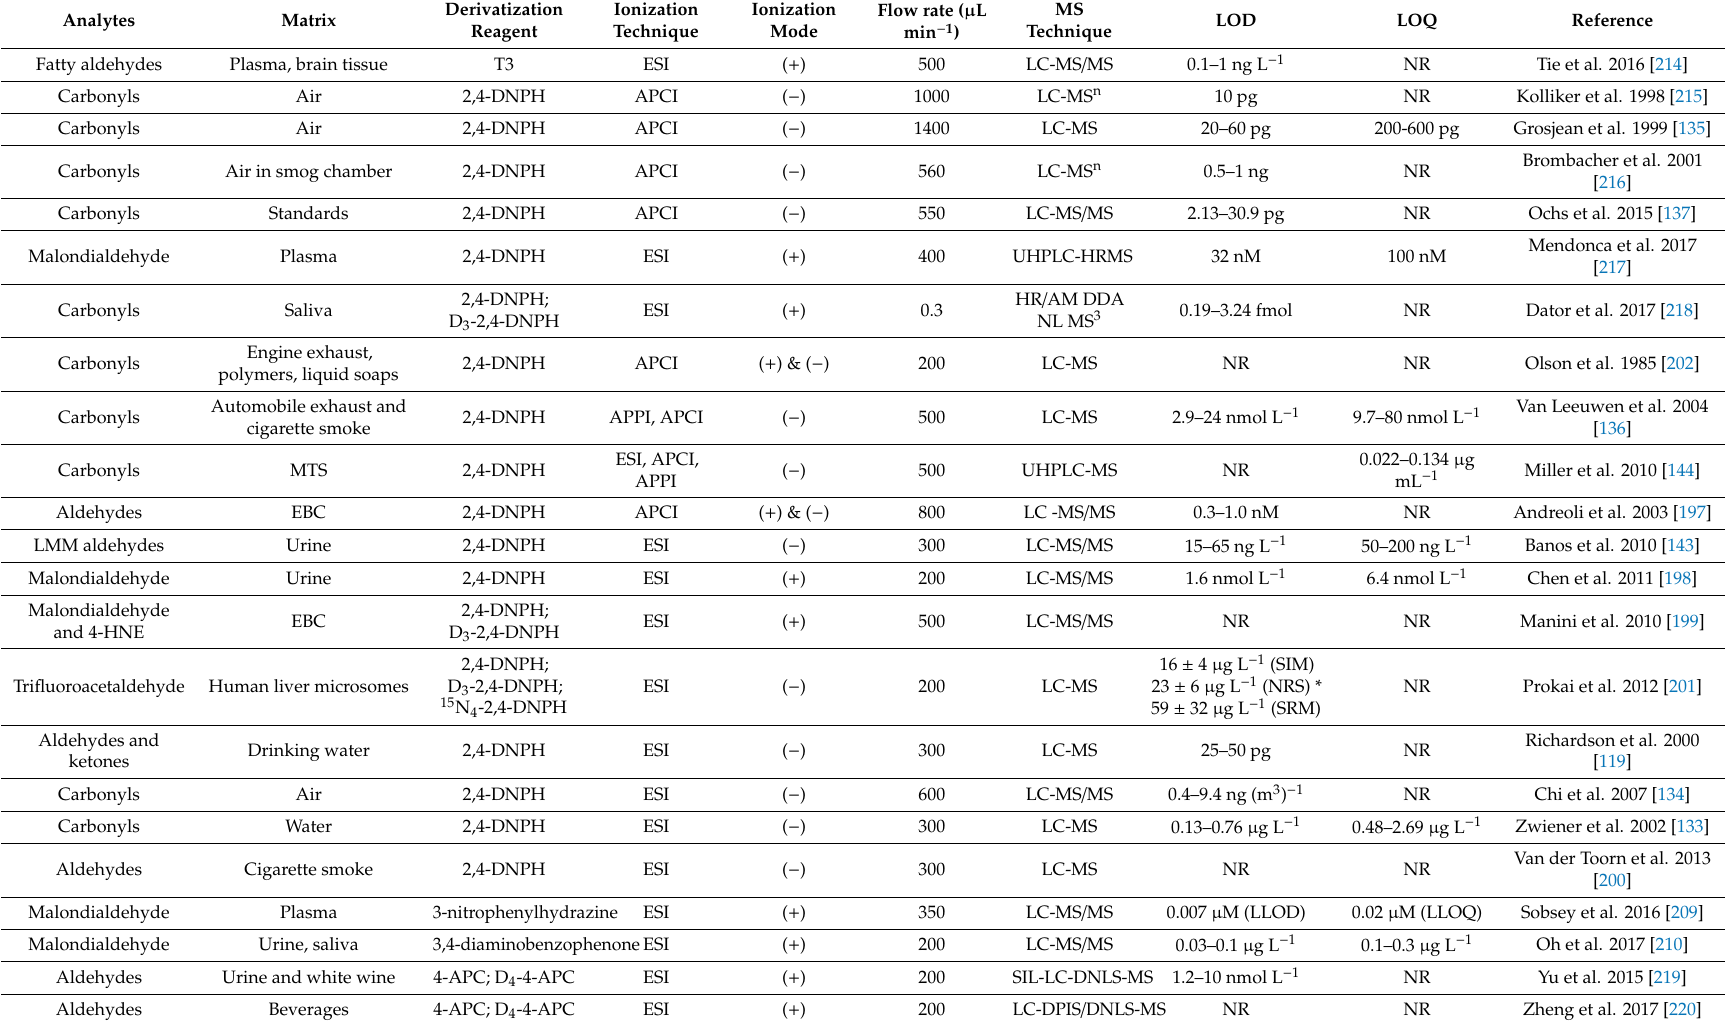
Table 3. LC-MS-based Methods for Characterizing